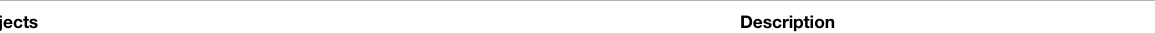
TABLE 2 | Simpli fi ed table presenting objects and operations analysis. Objects Description System state “ noti fi cations/activity/data fl ow ” Admin and auth